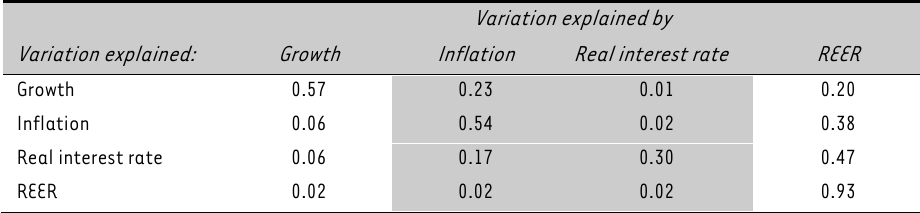
Variation explained by